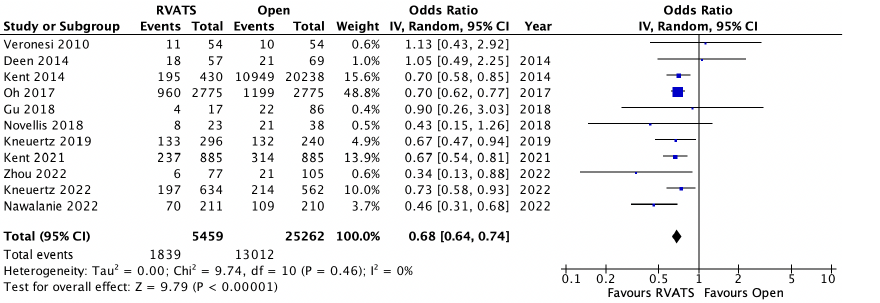
Figure 3. Overall complications in patients who underwent robotic video-assisted thoracoscopic surgery compared with open thoracotomy for resectable non-small cell lung cancer [8–10,13,16,17,19,24,25,28].